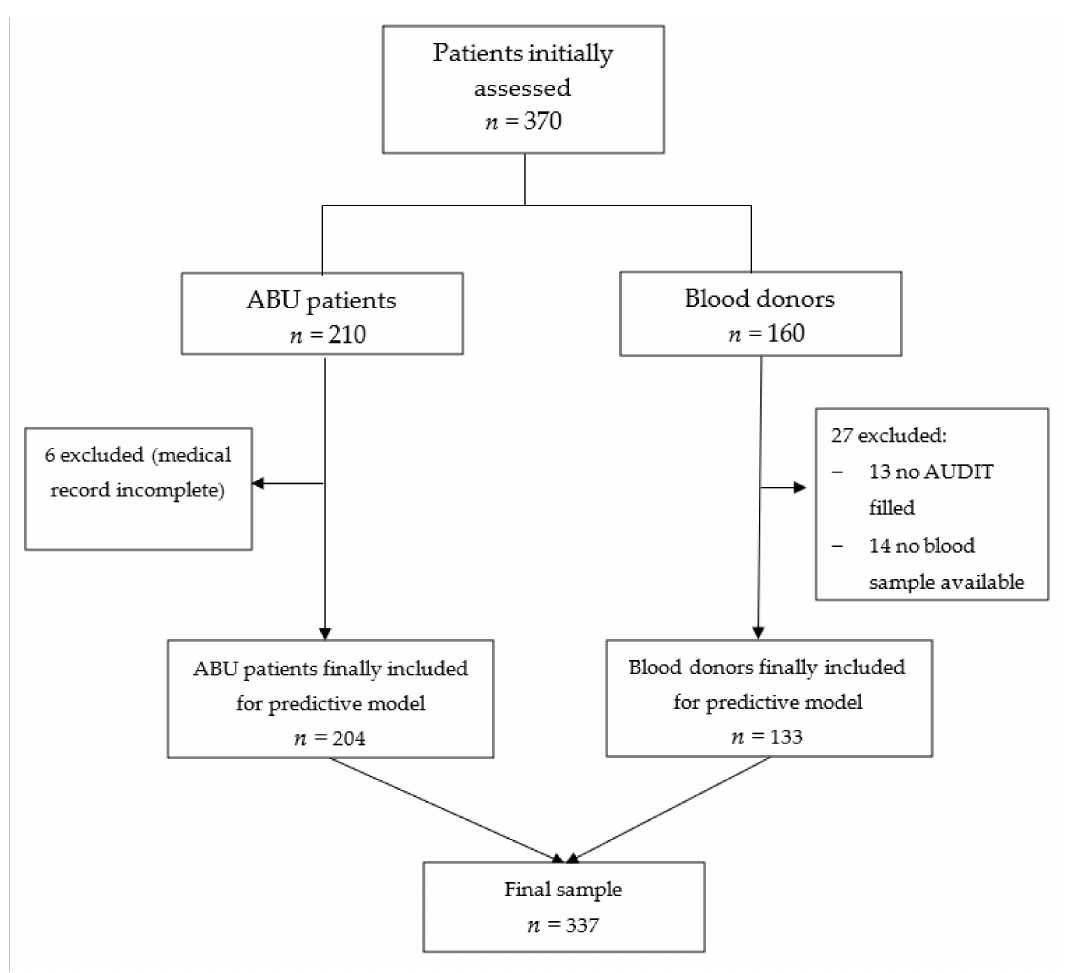
Figure 1. Flow chart of the